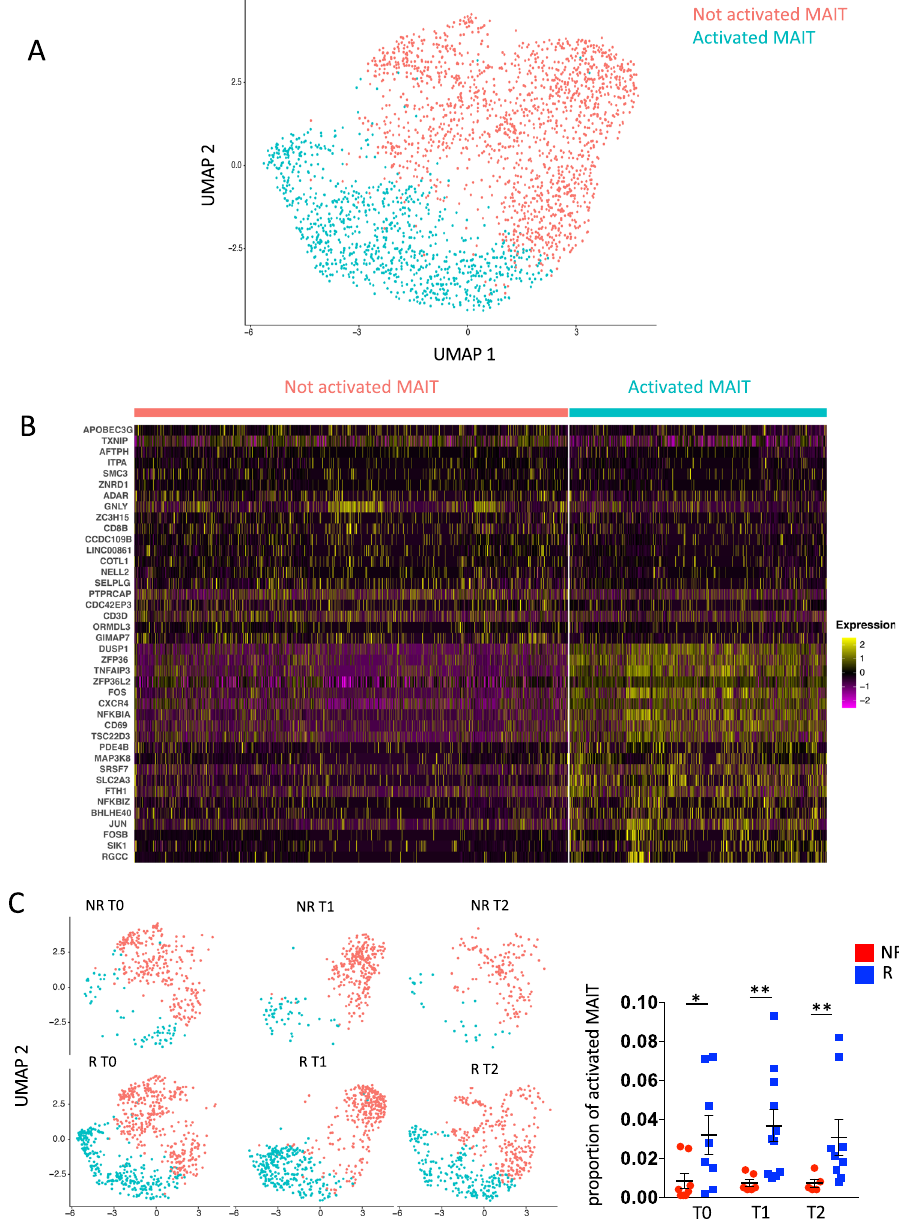
Fig. 3 Activated MAIT cells with homing properties are more abundant in responders. A UMAP plot of MAIT cells. Not activated MAIT are in salmon and activated ones are in light blue. B Heatmap displaying scaled-expression values of discriminative gene set per each cluster of MAIT cells. A list of representative genes is shown on the left. C Left part: UMAP plot representing two clusters of MAIT cells between R and NR at T0, T1, T2. Right part: Proportion of activated MAIT cells between R and NR at T0, T1, T2. * p = 0.04; T1, ** p = 0.005; T2, ** p = 0.007. Statistical analysis by two-sided Mann – Whitney nonparametric test, Bonferroni ’ s multiple comparisons test. T0 = before therapy, T1 = after 1 cycle of therapy, T2 = after two cycles of therapy. Individual measurements of NR = 8, R = 11. Source data are provided as a Source Data fi